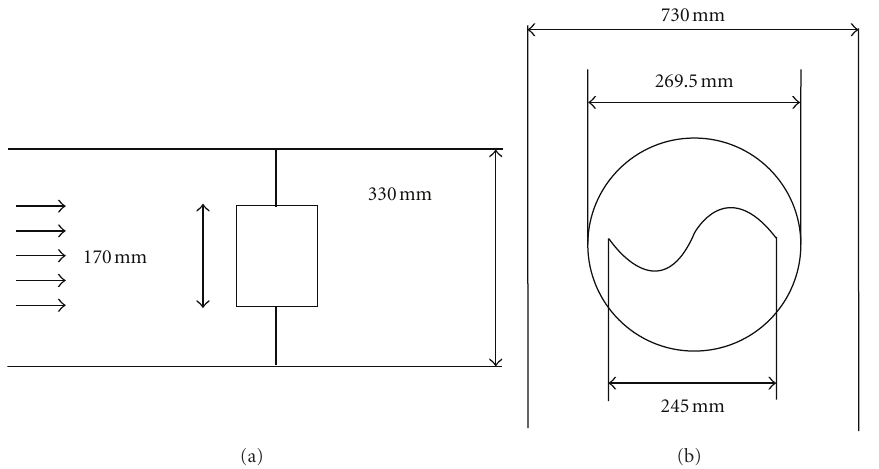
Figure 1: (a) Side view of the experimental setup and channel. (b) Top view of the experimental set-up channel.